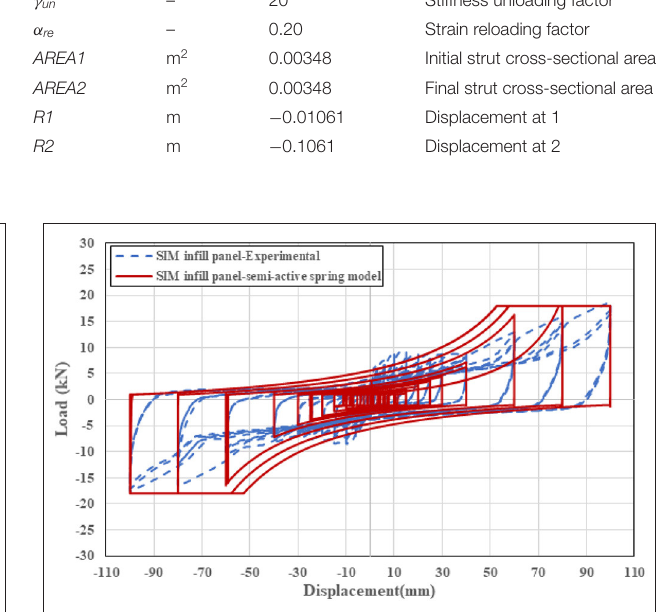
FIGURE 19 | Comparison between the force–displacement experimental and numerical curves of the semi-interlocking masonry (SIM) infill.